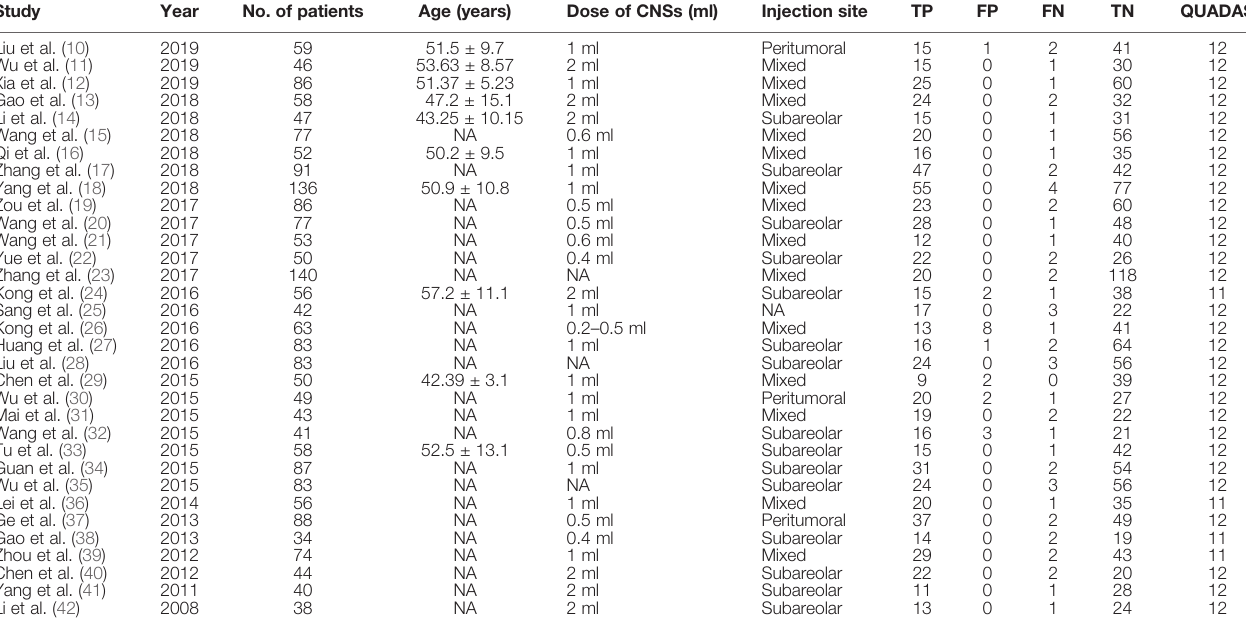
TABLE 1 | Detailed characteristics and QUADAS scores of the included study.